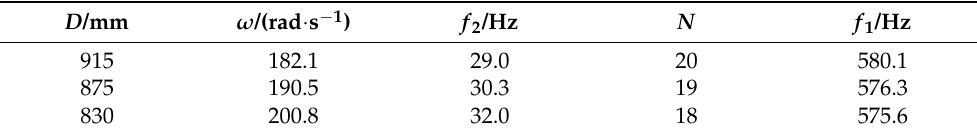
Table 1. Analysis of wheel polygonal wear